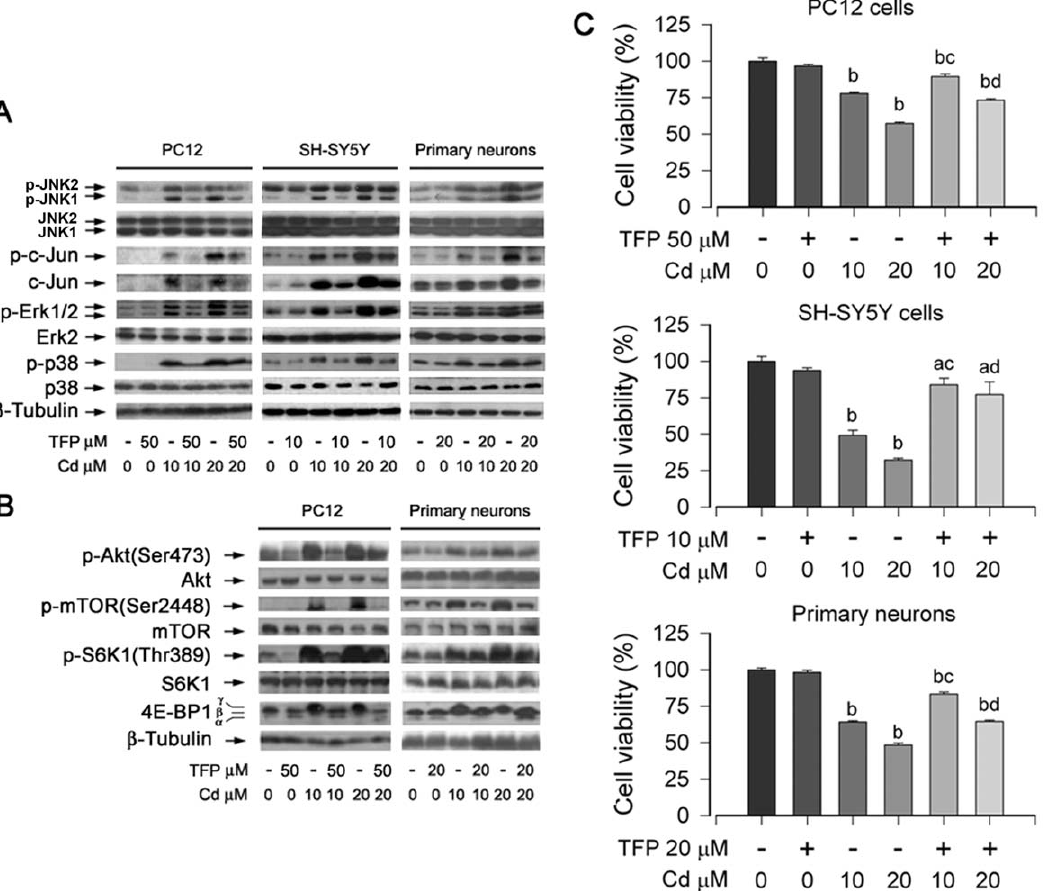
Figure 4. Inhibition of CaM by TFP attenuates Cd activation of MAPK/mTOR and apoptosis in neuronal cells. Indicated cells were pretreated with/without TFP at indicated concentrations for 30 min, and then exposed to Cd (10 and 20 m M) for 4 h (A, B) or 24 h (C). (A and B) Indicated cell lysates were subjected to Western blotting using indicated antibodies. The blots were probed for b -tubulin as a loading control. Similar results were observed in at least three independent experiments. (C) Cell viability for indicated cells was evaluated using one solution assay. Results are presented as mean 6 SE; n =6. a P , 0.05, b P , 0.01, difference vs. control group; c P , 0.01, difference vs. 10 m M Cd group; d P , 0.01, difference vs. 20 m M Cd group.